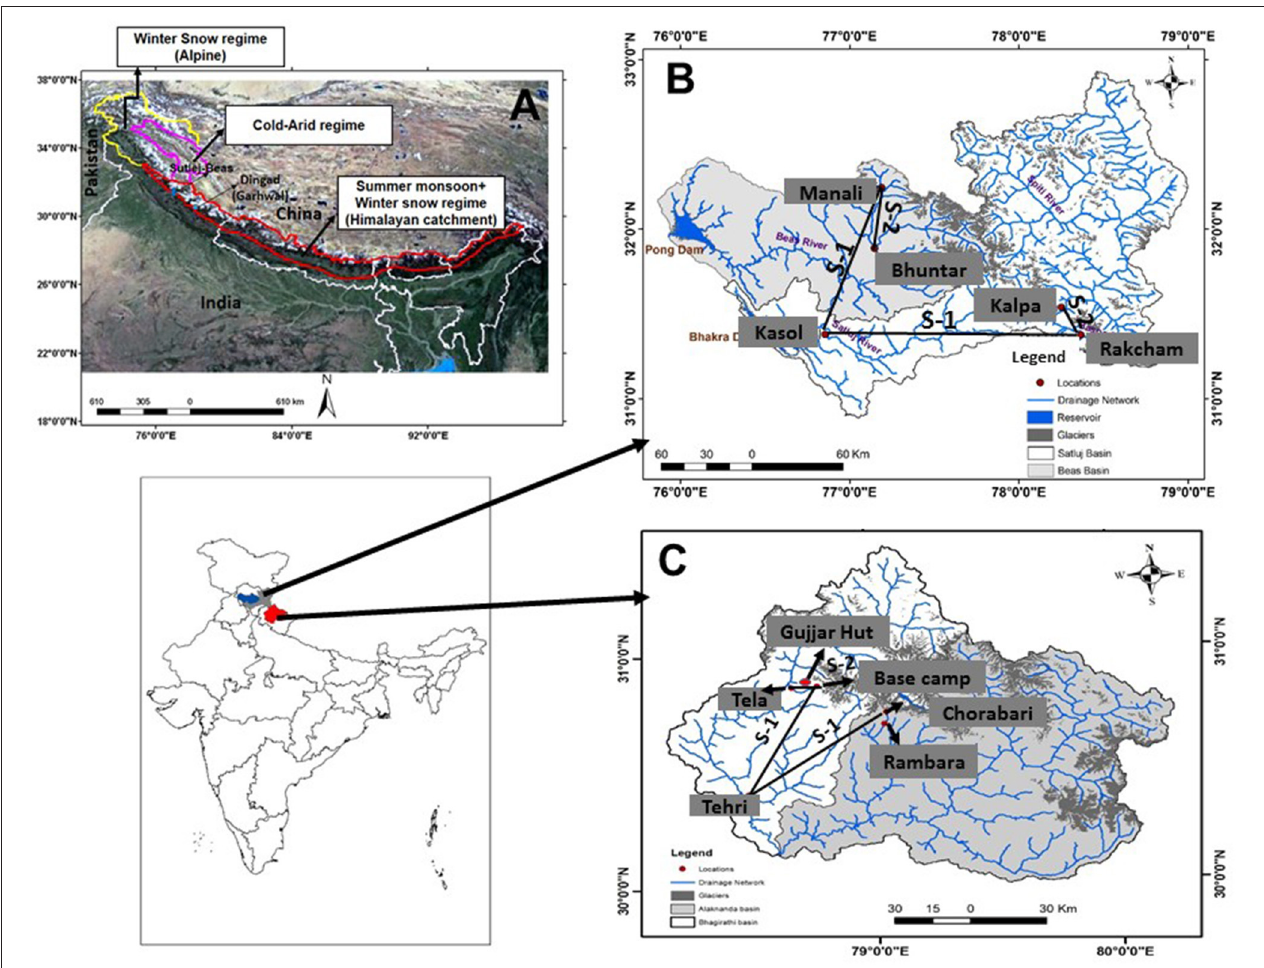
FIGURE 1 | (A) Glacio-hydrological regimes of southern slopes of the Himalaya and study area (after Thayyen and Gergan, 2010) and study basins in the monsoon regime: (B) Sutlej and Beas basins (C) Bhagirathi and Alakanada basins in the upper Ganga basin.